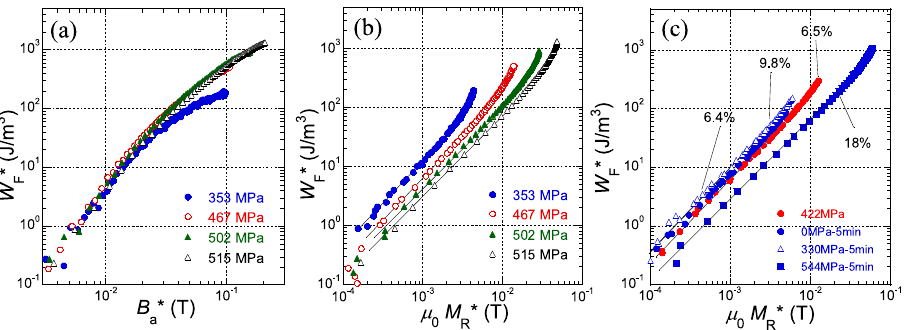
Figure 4. The relationship ( a ) between hysteresis loss ( W F *) and maximum flux density ( B a *) and ( b ) between W F * and remanence ( M R *) plotted on a double logarithmic scale before and after plastic deformation. ( c ) The relationship between W F * and M R * plotted on a double logarithmic plot before and after cooling at 77 K for 5 min. In ( c ), data obtained after cooling is shown as blue symbols. The number denoted in ( c ) is the volume fraction of α′ -martensites. The solid lines in ( b , c ) denote the least-squares fitting lines.